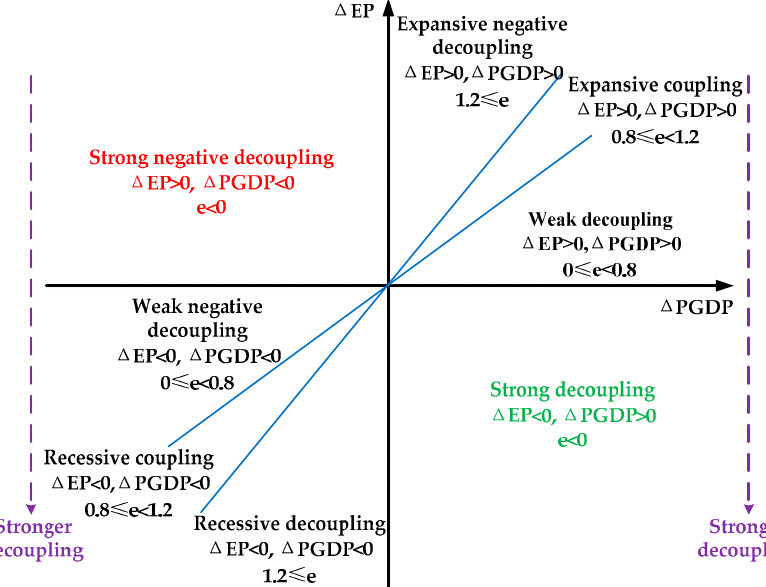
Figure 1. Judgments matrix of decoupling based on the Tapio decoupling model. PGDP, per capita gross domestic product. ∆ EP represents the change in industrial “three wastes” emissions. ∆ PGDP represents the change in per capita GDP.